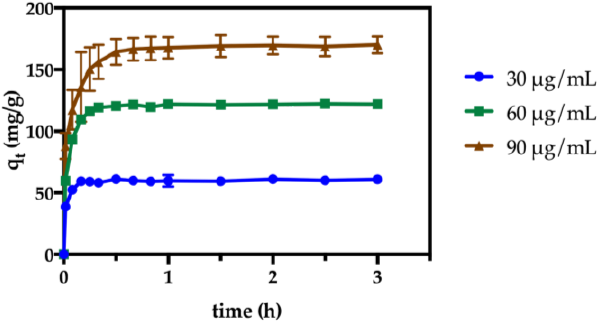
Figure 5. Time profile of adsorption capacity of κ-carrageenan hybrids at variable paraquat initial concentrations (pH 7.3, 25 °C).